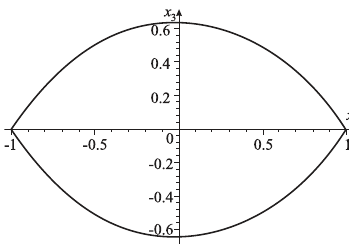
Fig. 1. Cross section of the (cid:12)gure in the Ox 1 x 3 plane.